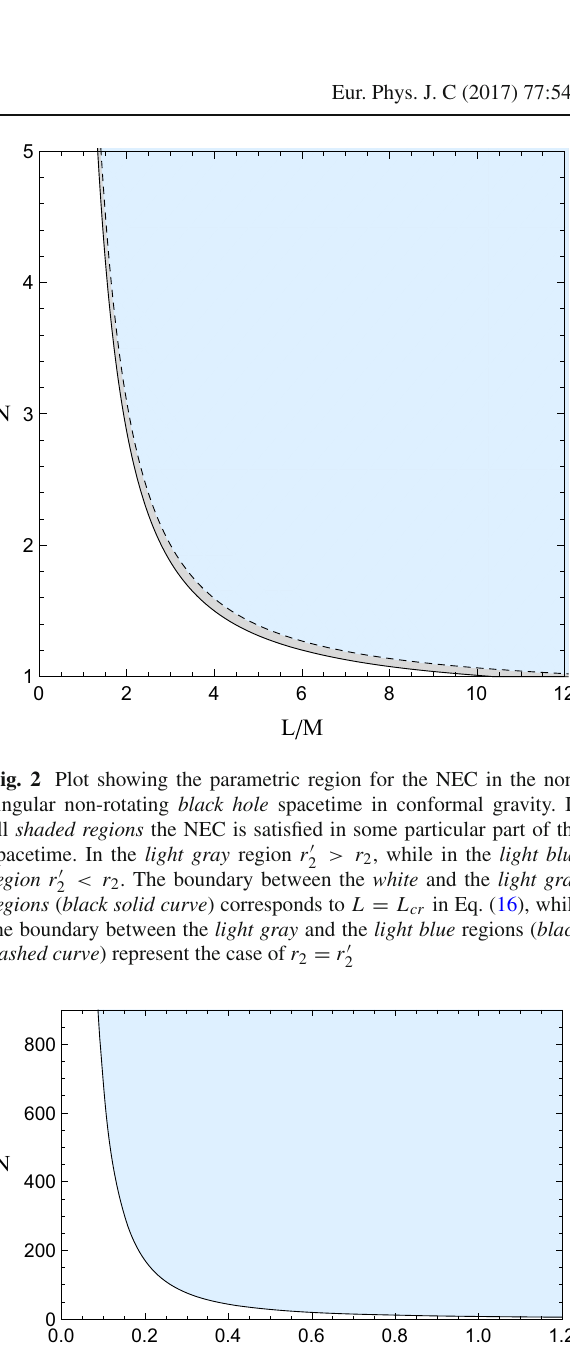
, r (cid:10) ] ( shaded region ) when L / M < 1 . 2. The 2 3